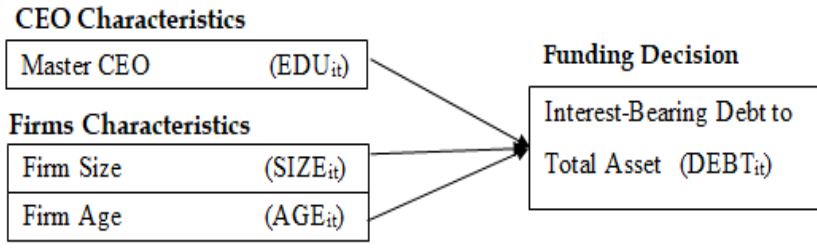
Figure 1. A conceptual framework for model